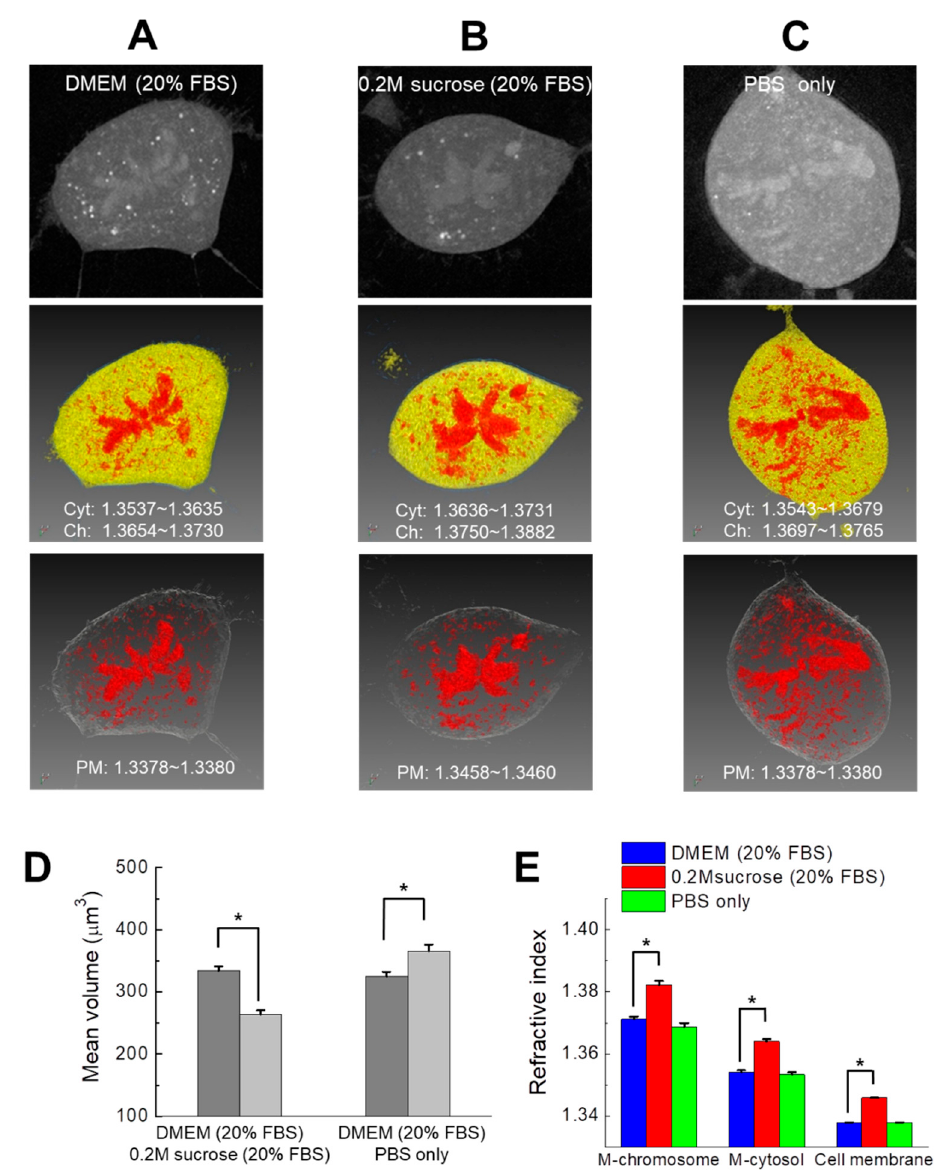
Figure 2. Detection of RI changes in chromosomes of DM cells under different osmotic conditions. ( A – C ) Representative raw optical diffraction tomography (ODT) 3D images (upper), pseudocolored RI 3D images (center) of cytosol (yellow), chromosomes (red), and plasma membranes (blue) during metaphase of live DM cells under normal (DMEM), hypertonic (0.2 M sucrose), and hypotonic (PBS) conditions respectively. For clarity, pseudocolored RI images of plasma membranes (white) and chromosomes (red) are shown (bottom). The pseudocolor images of mitotic cytosol and chromosomes are represented by yellow and red, respectively. Corresponding RI ranges of mitotic cytosol (Cyt) and chromosomes (Ch) are indicated (inset). ( D ) The mean change of volumes change of all chromosomes of one mitotic cell after media exchange was evaluated using 3D confocal imaging of individual DM cells expressing H2B-mRFP (mean ± standard error of the mean (SEM); n = 25 cells). Identical single DM cells were respectively traced and imaged before (gray) and after (light gray) media exchange as indicated. * p < 0.01. ( E ) Mean values of RI of mitotic chromosomes in metaphase, cytosol, and membranes under each condition (mean ± SEM; n = 20 cells). The RI value of the cell membrane was mostly independent of the media conditions. M denotes mitotic cells. * p < 0.01 for M-chromosome and M-cytosol and * p < 10 − 6 for cell membrane.